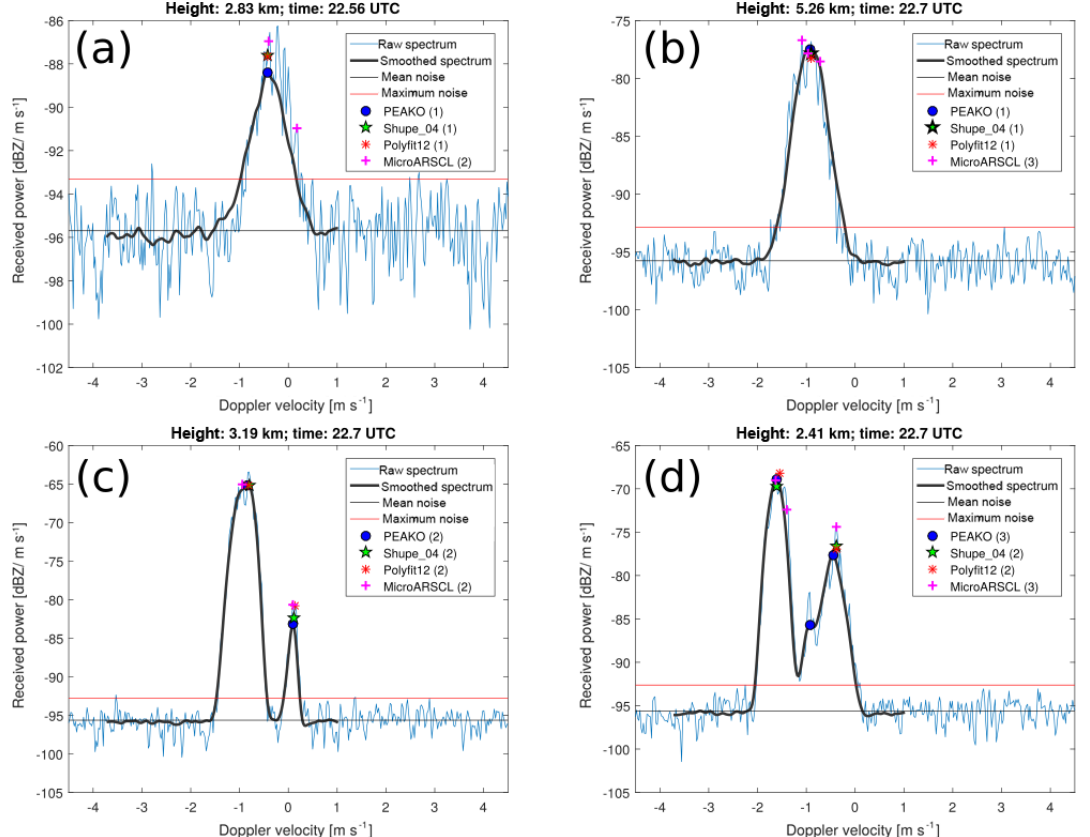
Figure 7. Four exemplary Doppler spectra picked from the case study on 21 February 2014, 22.54 to 22.77UTC, at 2 to 6km altitude. The averaged and smoothed spectrum which is used as input to PEAKO is drawn in bold over the original spectrum. The peaks detected by the four algorithms are marked. The number of peaks found by each algorithm is noted in parentheses in each figure legend. Please note the different y